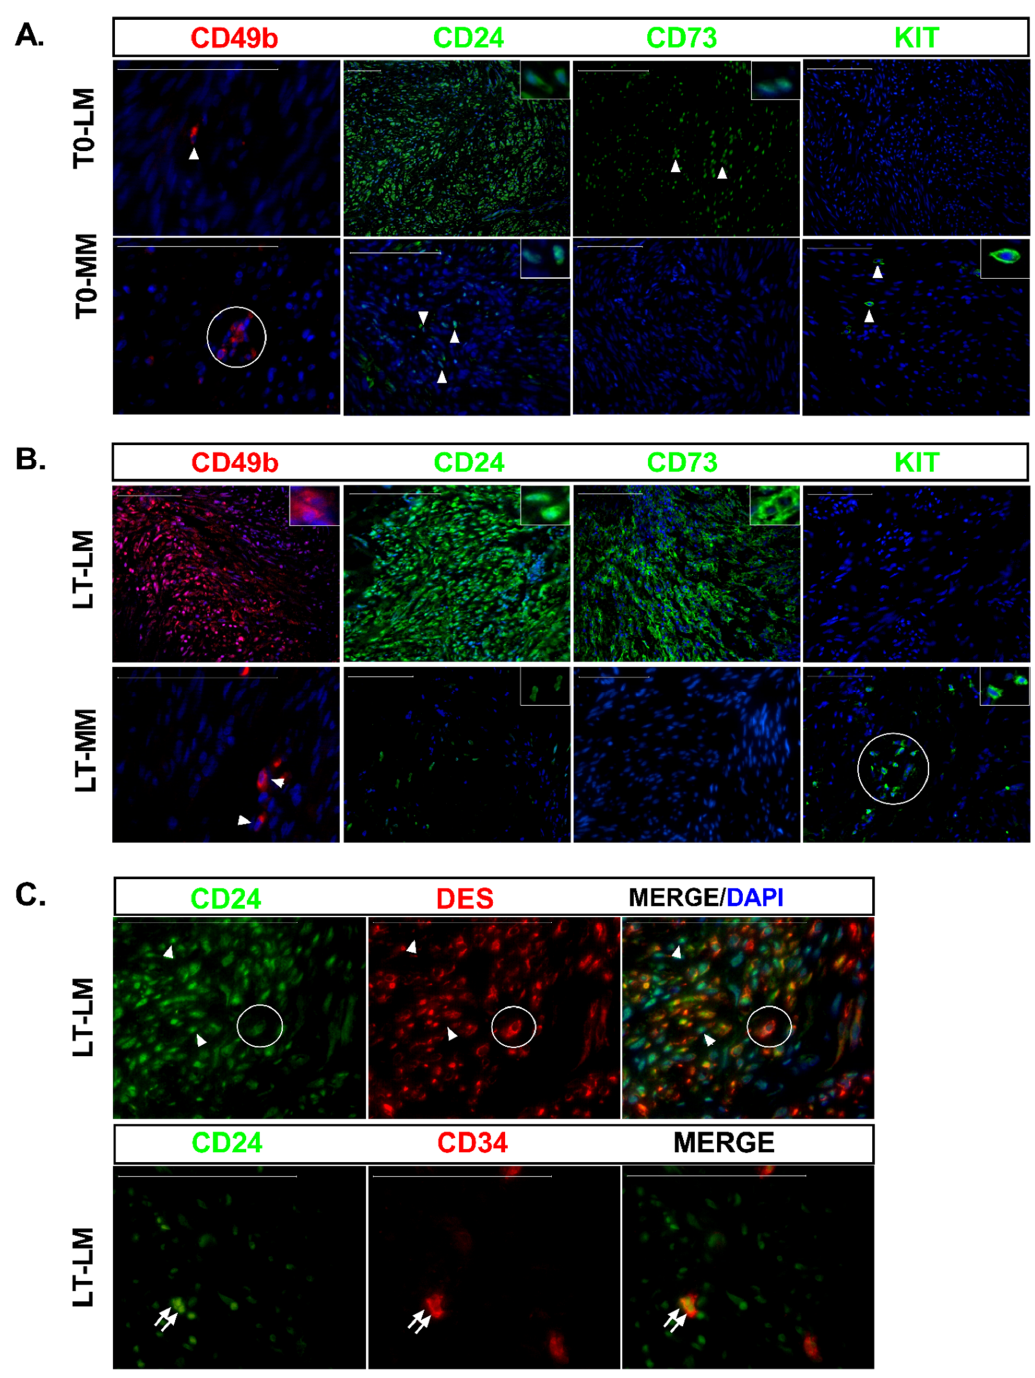
Figure 2. Expression of stem cell and undifferentiated surface markers in leiomyoma and myometrial slices at baseline and long-term culture. ( A ) IF staining of CD49b (red), CD24 (green), CD73 (green), and KIT (green) in leiomyoma (LM) and myometrium (MM) at baseline (T0). DAPI stained cell nucleus (blue). Detailed immunostaining is depicted in the insert. Arrowhead indicates immunostained cells. ( B ) Same marker described in ( A ) at long-term culture (LT). Detailed immunostainings are depicted in the inserts. Arrowhead indicates the CD49b + cells detected in the myometrium. KIT staining in myometrium was found dispersed or in grouped cells (circle). In all sections, nuclei were counterstained with DAPI (blue). ( C ) Extensive colocalization of CD24 (green) with DES (red) in long-term culture slices was observed in LM slices (circle cells), but CD24 + /DES − cells were also detected (arrowheads). Colocalization of CD24 (green) and CD34 (red) in two LM cells (arrow). Scale bar, 100 µ